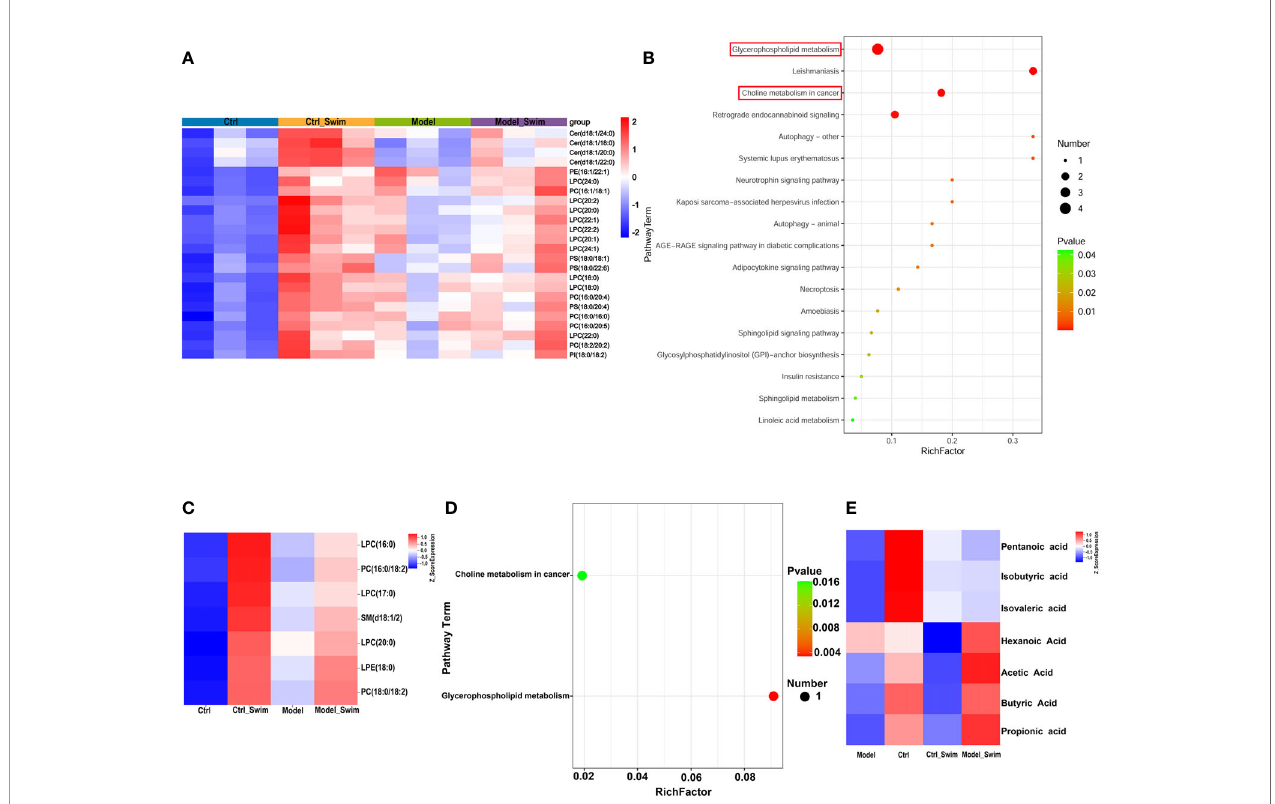
FIGURE 5 | Lipid metabolism changes in colonic environment induced by AOM/DSS and swimming pretreatment. (A) Heatmap of 24 differential colonic lipid metabolites with functional enrichment. (B) KEGG enrichment analysis of the differential colonic lipid metabolites caused by swimming in AOM/DSS-induced CAC Mice. (C) Heatmap of 7 differential fecal lipid metabolites caused by swimming in AOM/DSS-induced CAC Mice. (D) KEGG enrichment analysis of the differential fecal lipid metabolites caused by swimming in AOM/DSS-induced CAC Mice. (E) Heatmap of fecal SCFAs alteration by swimming in AOM/DSS-induced CAC